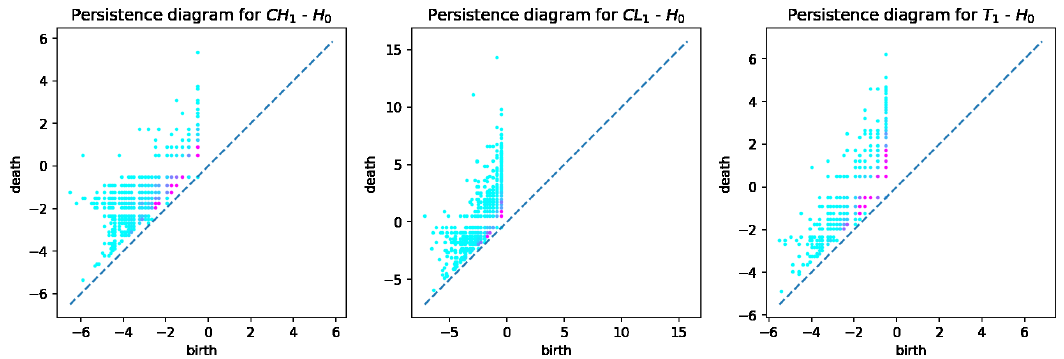
Figure 2. H 0 persistent diagrams for CH, CL, and T